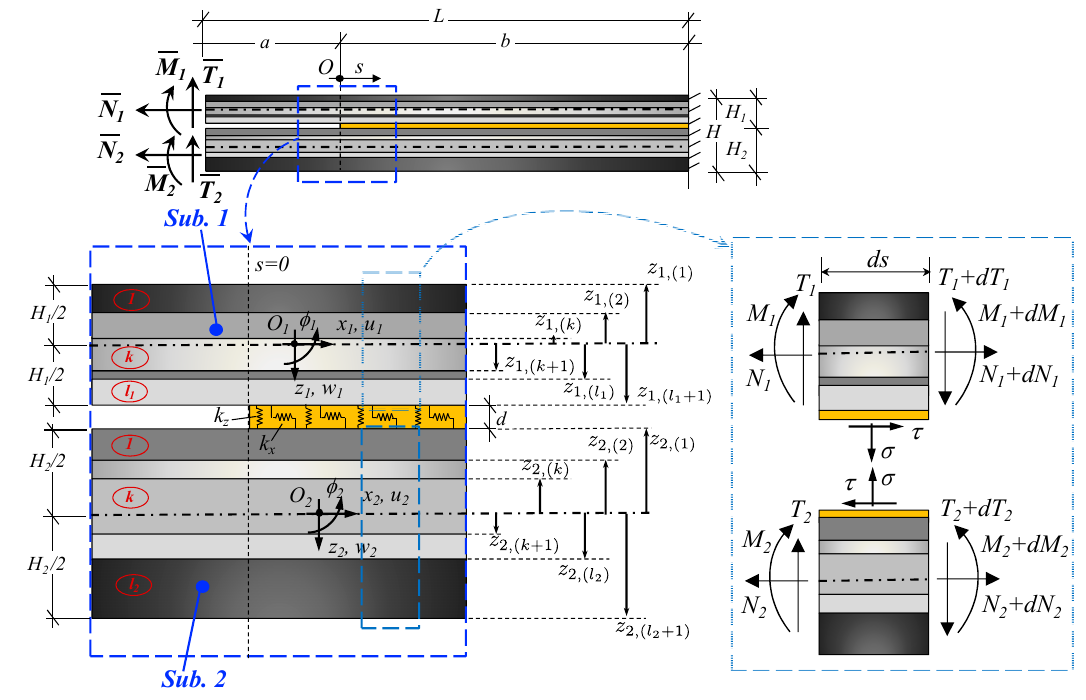
Figure 1. Mechanical scheme of the laminated composite specimen.